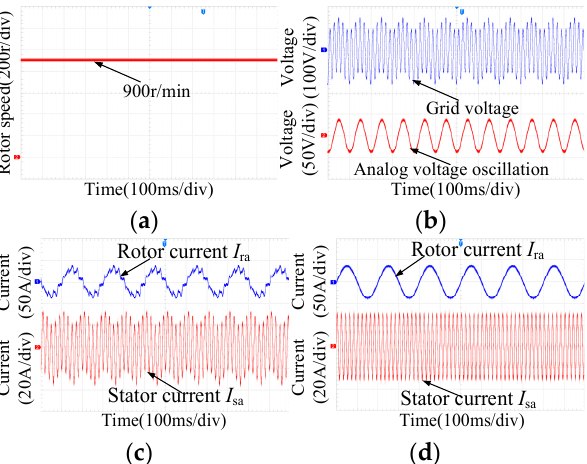
Figure 19. The oscillation suppression suppressed-contrast waveforms at SSO frequency of 10 Hz: ( a ) DFIG rotor speed; ( b ) grid voltage oscillation waveform; ( c ) before oscillation suppression; ( d ) after oscillation suppression.